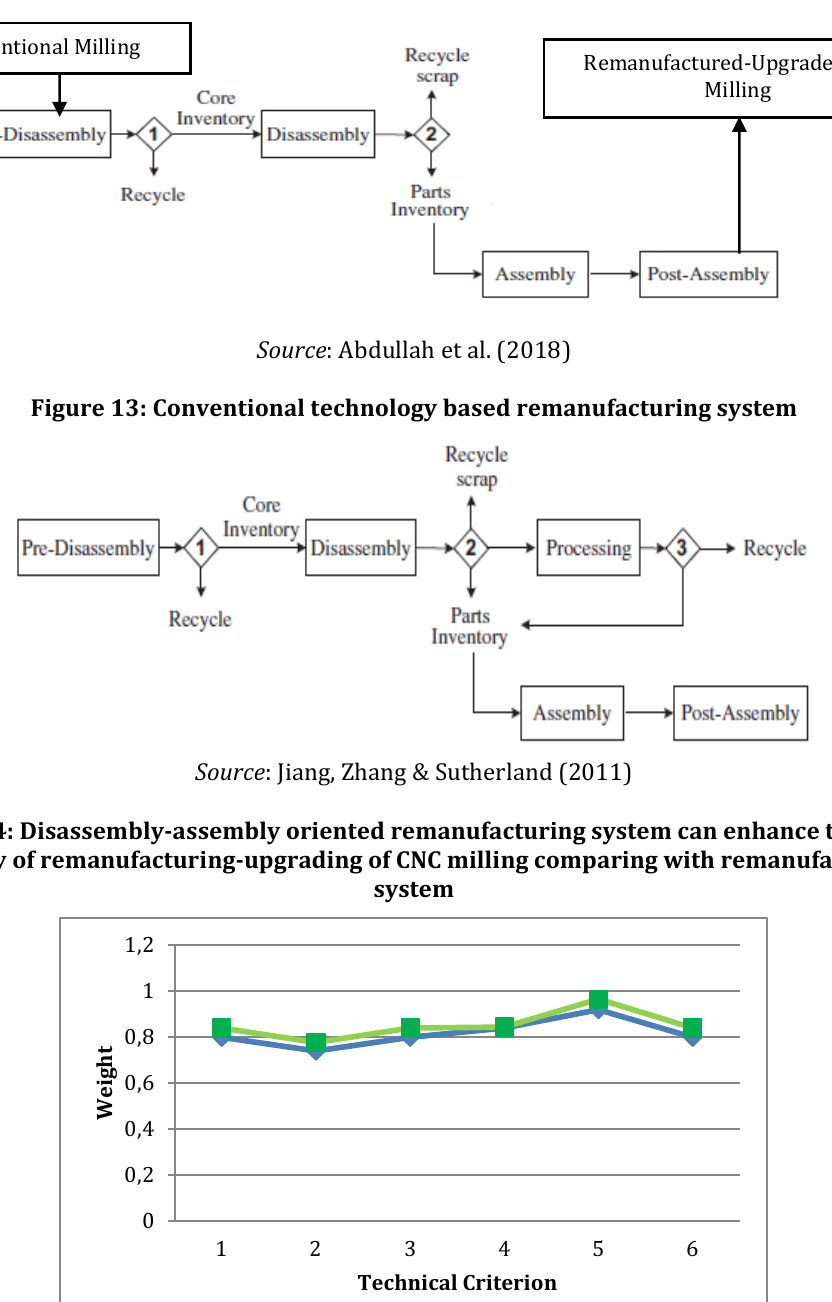
Figure 12: Proposed assembly-disassembly oriented remanufacturing system